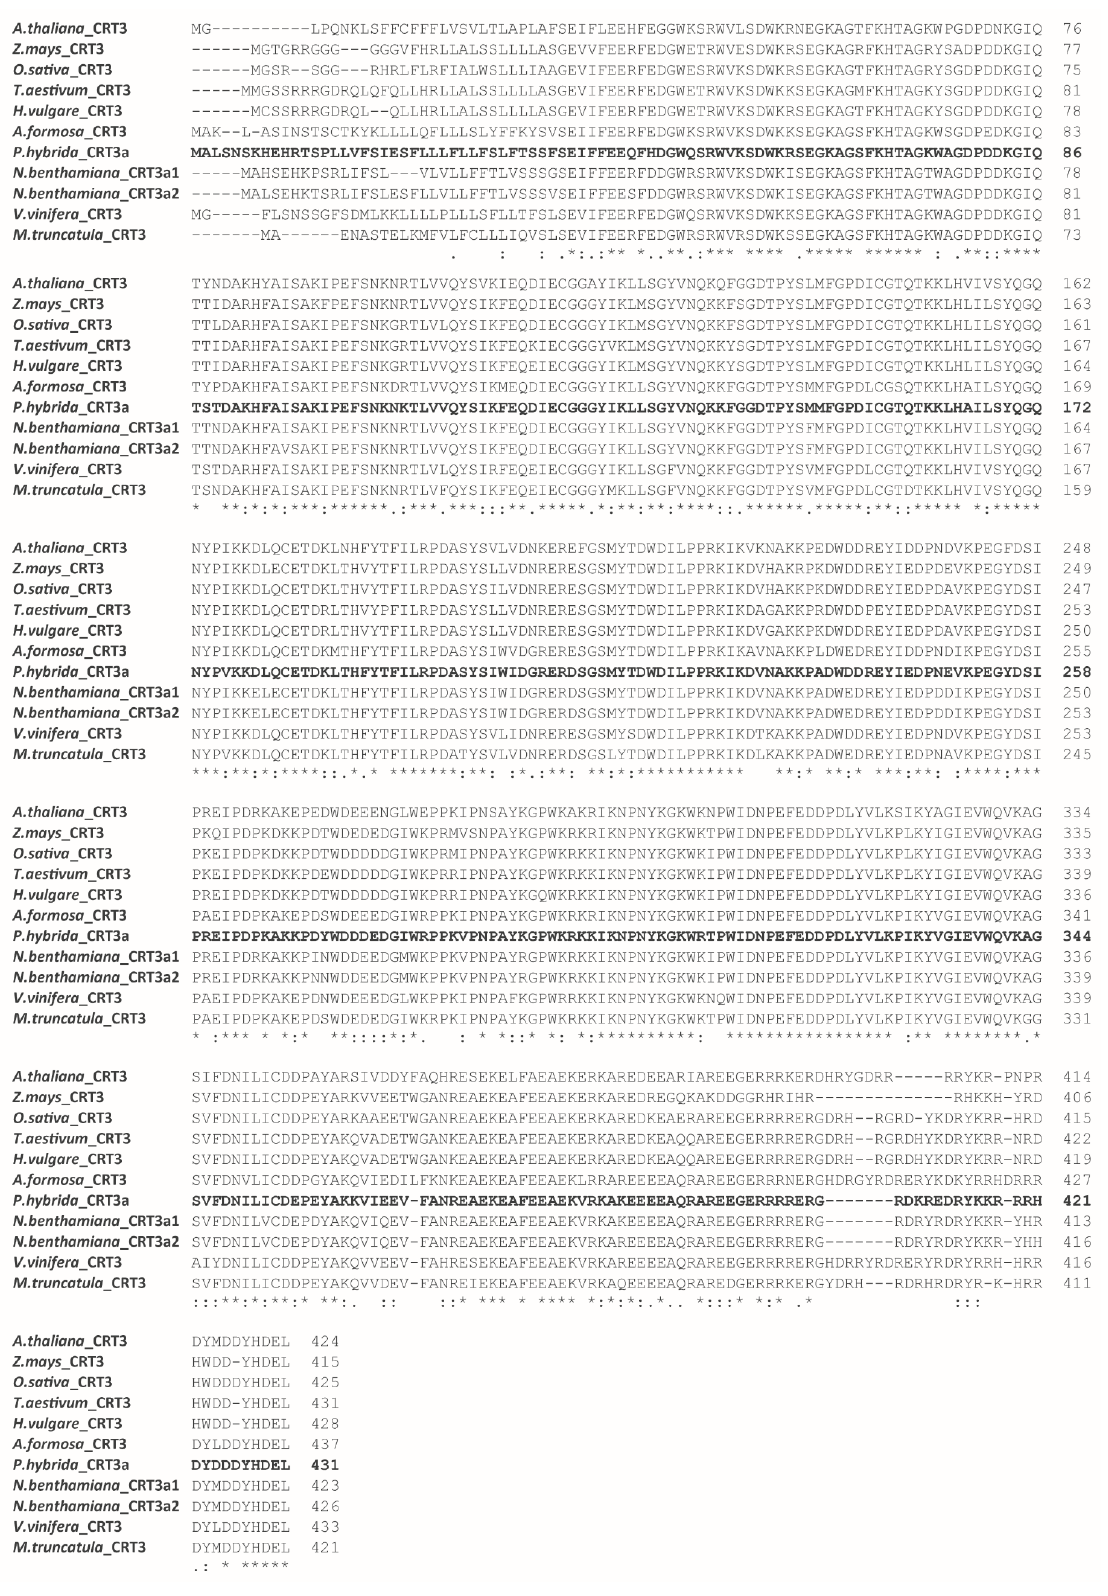
Figure 3. Sequence alignment of the newly identified Ph CRT3a with other plant CRT3 sequences: Oryza sativa (BAC06263.1), Triticum aestivum (ABR15365.1), Zea mays (translated from nucleotide sequence AY105822.1) [16], Aquilegia formosa (translated from nucleotide sequences DR940519.1